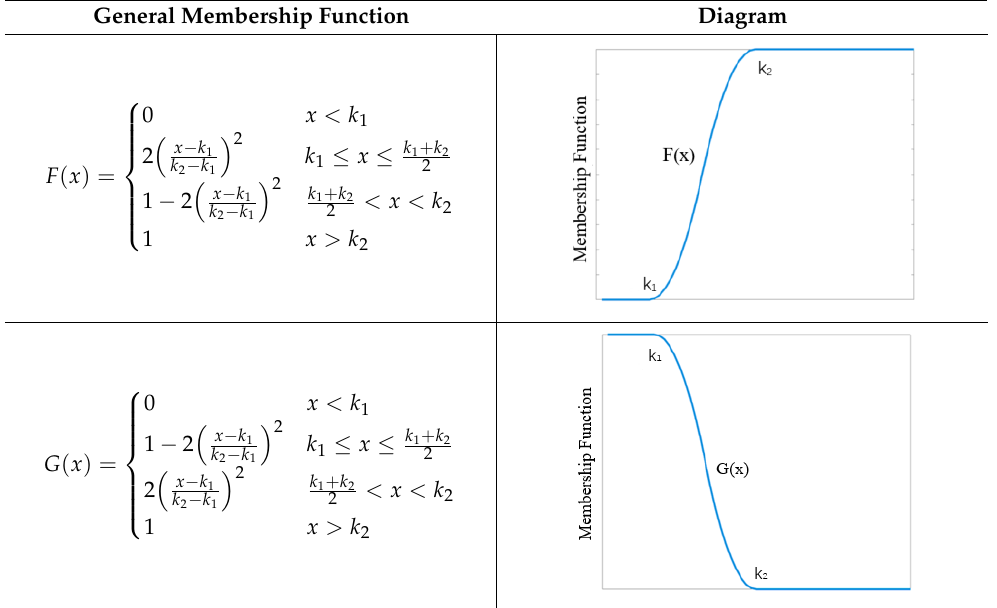
Table 5. The general membership functions of the ANFIS.